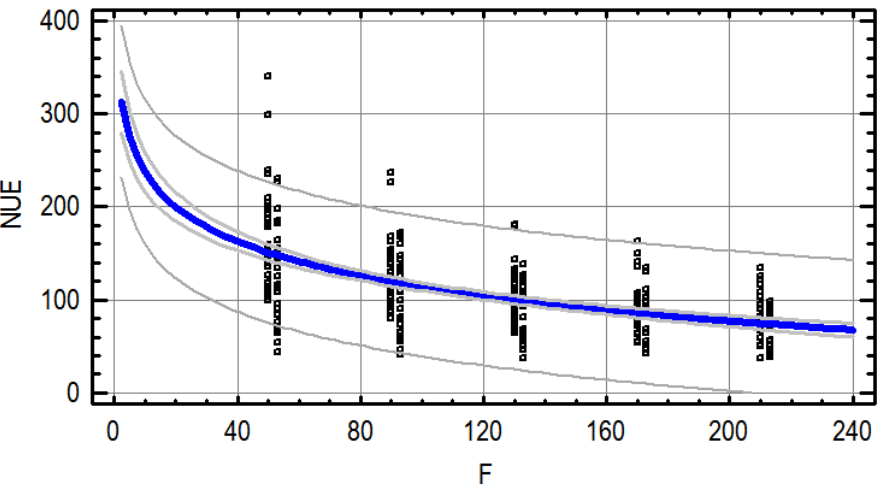
Figure 3. Observed and predicted nitrogen use efficiency (NUE, %) depending on nitrogen doses (F, kg N·ha −1 ) (R 2 = 32.9%, n = 320).